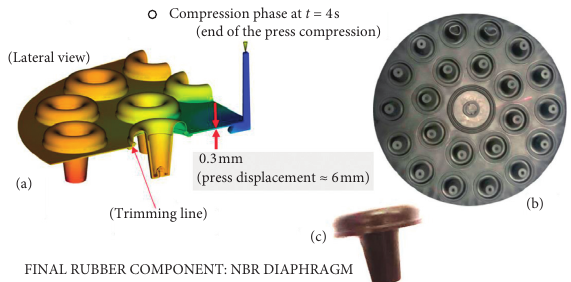
Figure 9: Final condition at the end of press compression (a) and the real part (c) obtained after trimming the molded part